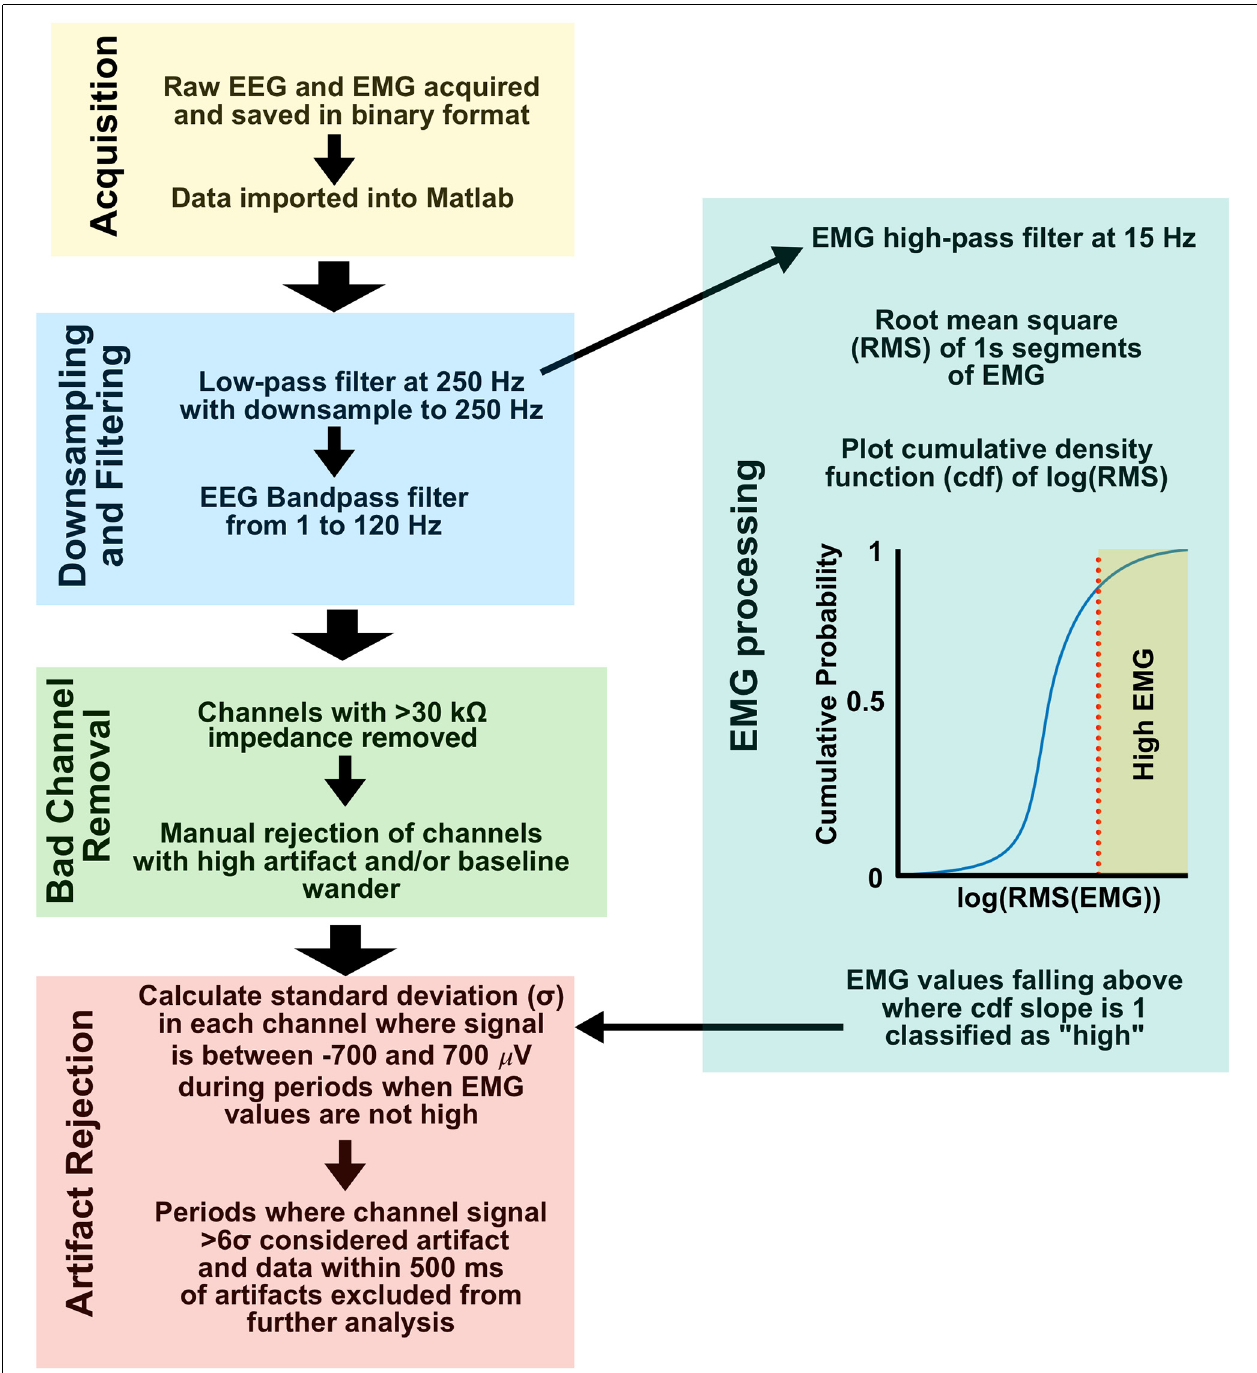
FIGURE 2 | EEG and EMG signal preprocessing. Workflow from acquisition to artifact rejection was used for all data in this study. EEG, electroencephalogram; EMG, Electromyography.